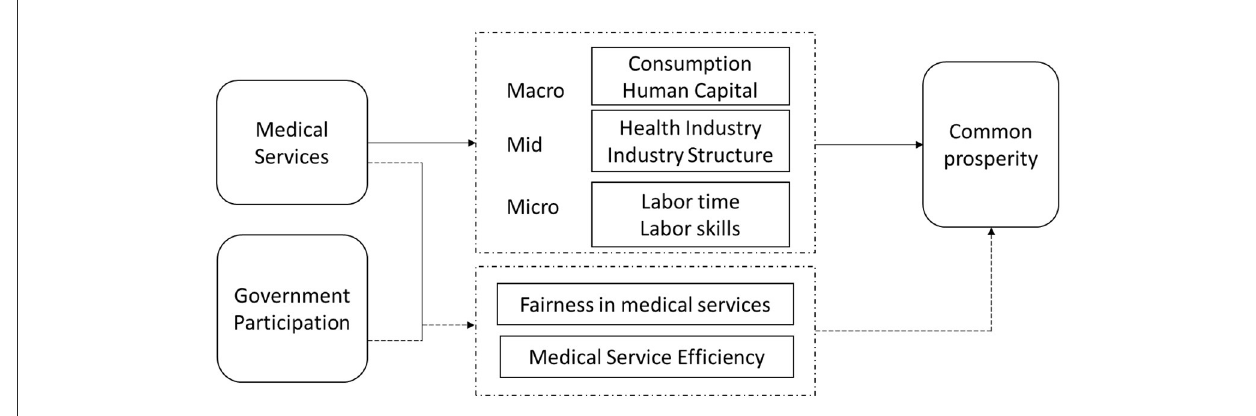
FIGURE1 Research framework and transmission pathways for government participation, medical services, and the common prosperity.